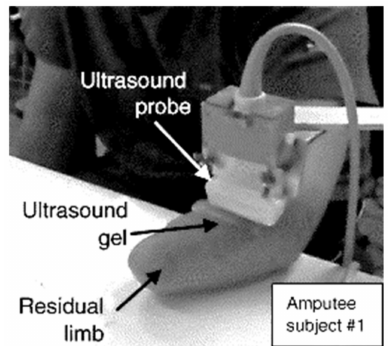
Figure 5. An example of a setup for collecting ultrasound images from the residual forearm of an amputee using a linear ultrasound probe. This figure was adapted from [71] with permission from